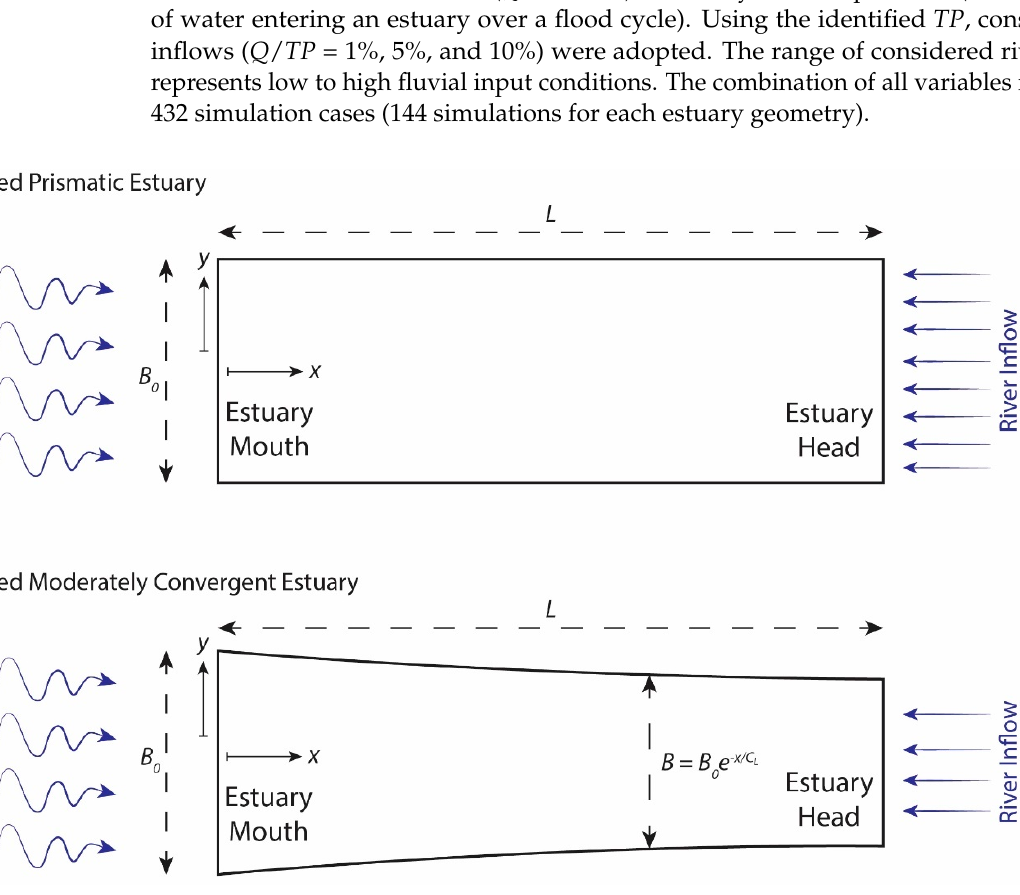
Figure 1. Plan view of different estuarine geometries investigated in this study including prismatic (top panel), converging with C L = 160 km (middle panel), and converging with C L = 80 km (bottom panel). All panels depict co-ordinate system, driving forces, and boundary conditions. 2.2. Tidal Properties To achieve the research objectives, three key tidal properties that provide insights into inundation, shoreline recession, failure of drainage systems, etc. were extracted along the central nodes for each of the investigated cases including tidal range, maximum cur- rent velocity, and tidal asymmetry. In this study, tidal range ( TR ) is defined as the differ- ence in the maximum water height during high tide ( 𝛿̅ (cid:3035)(cid:3036)(cid:3034)(cid:3035) ) and the minimum water height during low tide ( 𝛿̅ (cid:3039)(cid:3042)(cid:3050) ) measured along the central nodes of the estuaries: 𝑇𝑅 = 𝛿̅ (cid:3035)(cid:3036)(cid:3034)(cid:3035) − 𝛿̅ (cid:3039)(cid:3042)(cid:3050)